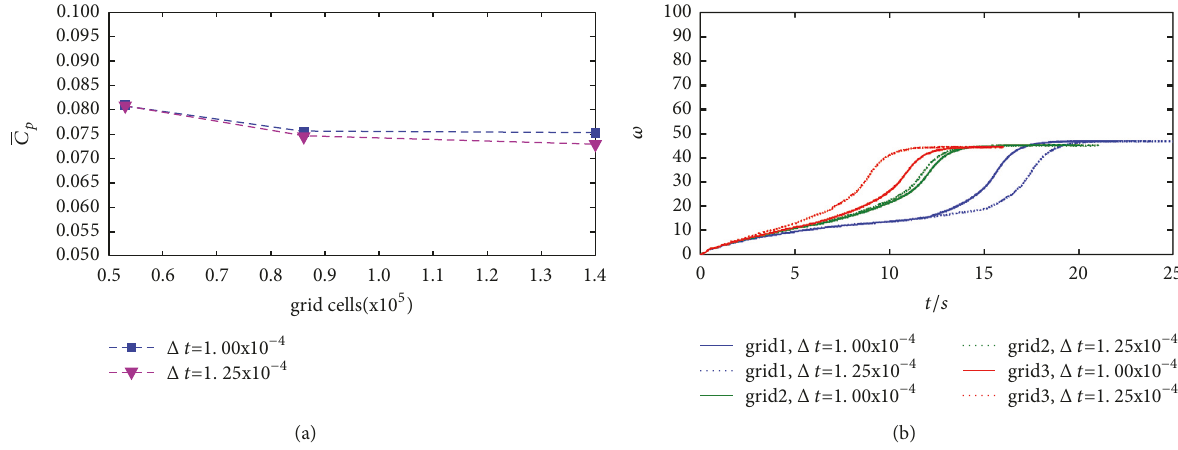
Figure 3: Evolution of mean power coefficient and passive rotation velocity of the VAWT for different levels of cells and time steps: (a) mean power coefficient and (b) passive rotation velocity.